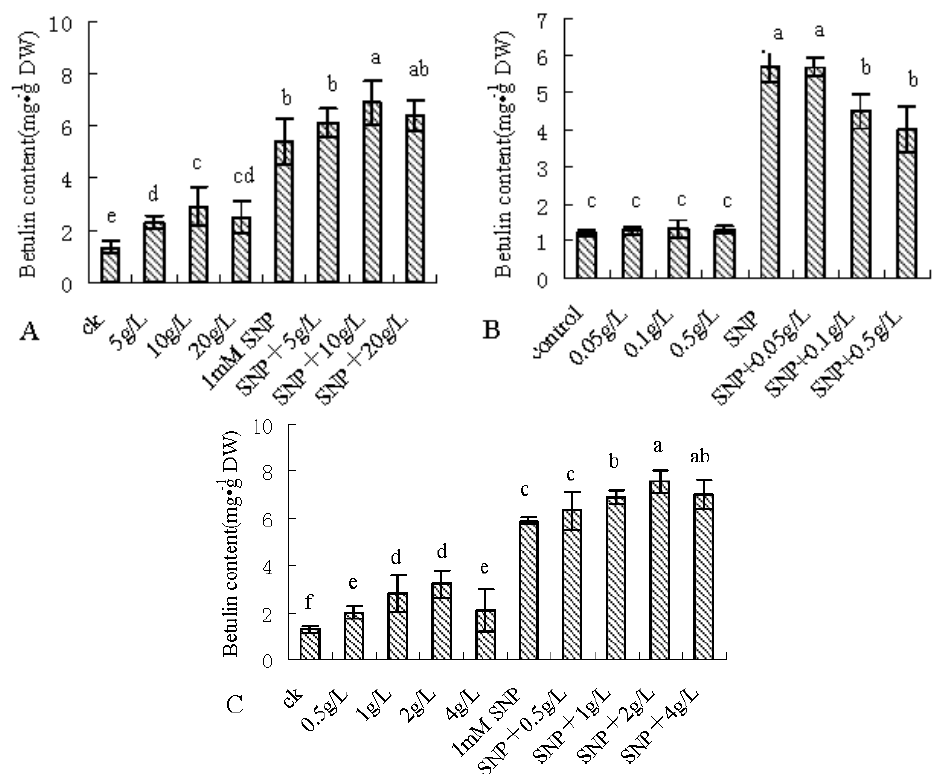
Figure 5. Effects of SNP combined with fructose, myo-inositol or phenylalanine on betulin content in birch suspension cells. 8-day-old suspension cells were treated with 1 mmol/L SNP combined with 3 g/L, 6 g/L, 10 g/L and 20 g/L fructose ( A ); 0.05 g/L, 0.5 g/L, 5 g/L myo-inositol ( B ); 0.5 g/L, 1 g/L, 2 g/L and 4 g/L phenylalanine ( C ); and harvested 12h after treatment. The letter explained the difference of data from statistical level. ( p < 0.05, Tukey’s test).